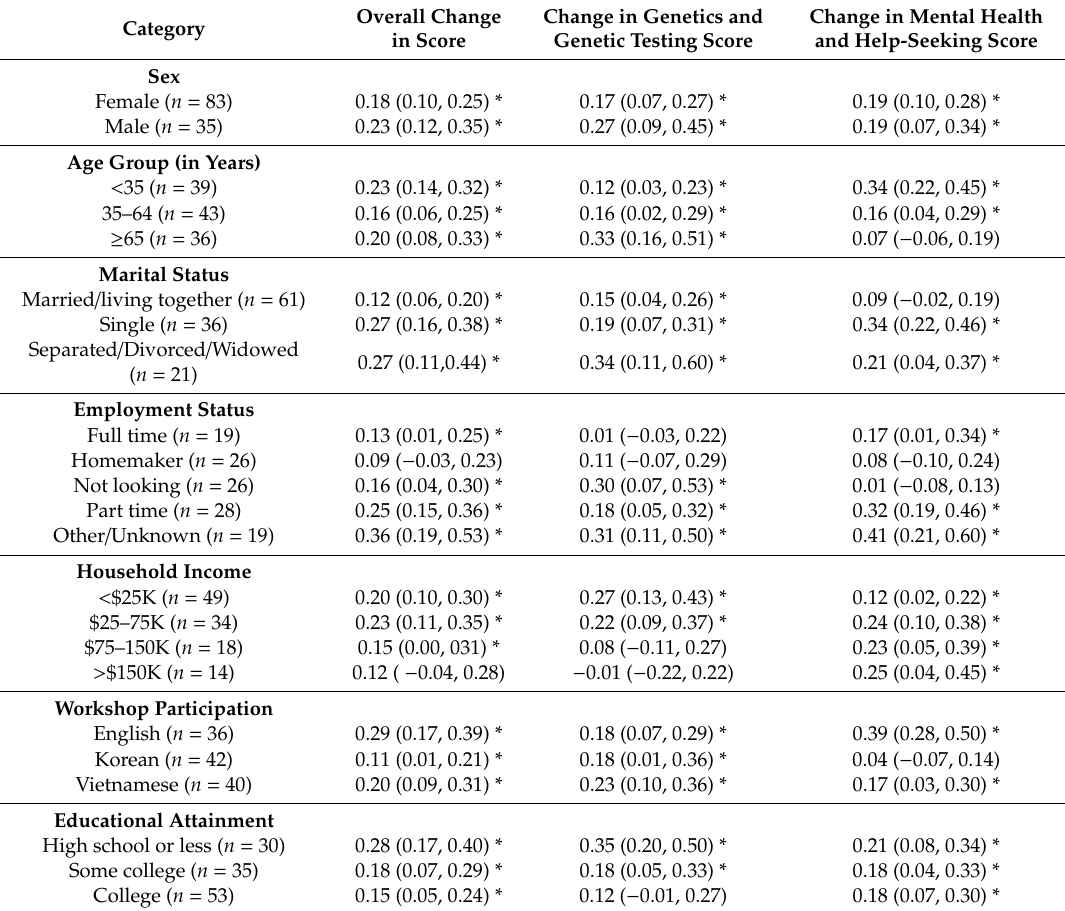
Table 3. Pre- and Post-Di ff erence in Summary Scores by Socio-demographic Characteristics: Overall, Genetics and Genetic Testing, and Mental Health and Help-Seeking ( n = 118). Overall Change Change in Genetics and Change in Mental Health Category in Score Genetic Testing Score and Help-Seeking